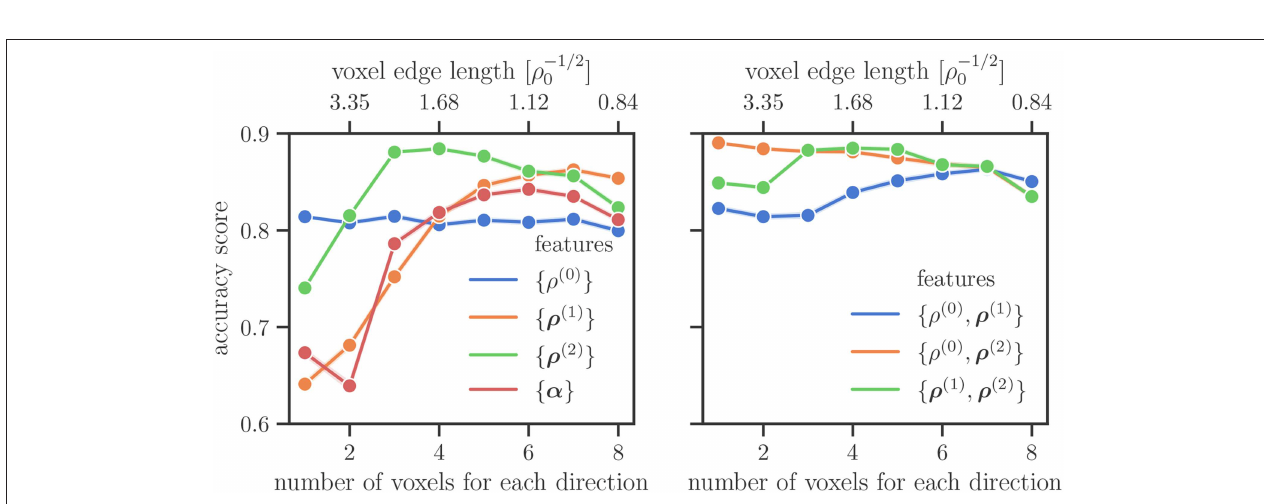
ρ (1) , ρ (2) ρ (0) , ρ (2) and coincide { } { }